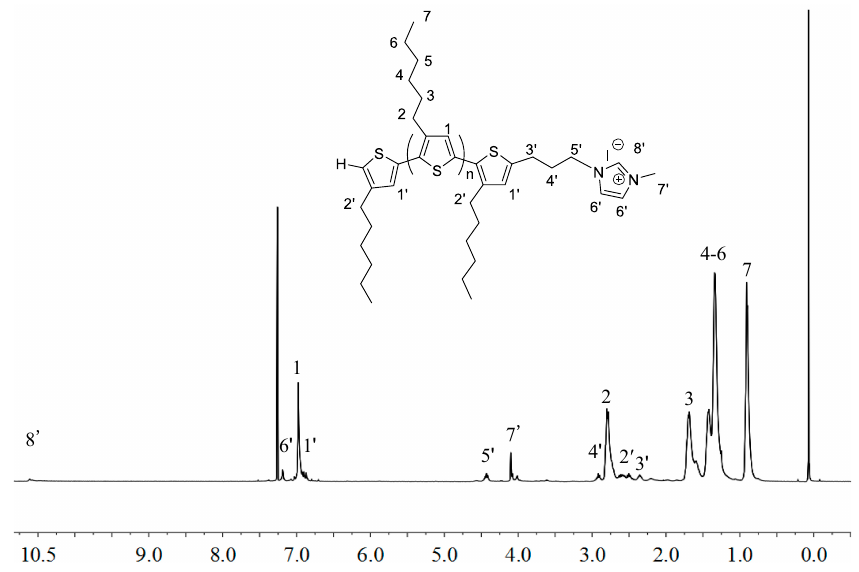
Figure 4. 1 H-NMR (400 MHz, CDCl 3 ) spectrum of P3HT-(CH 2 ) 3 -MIM with MW~2000 g/mol.